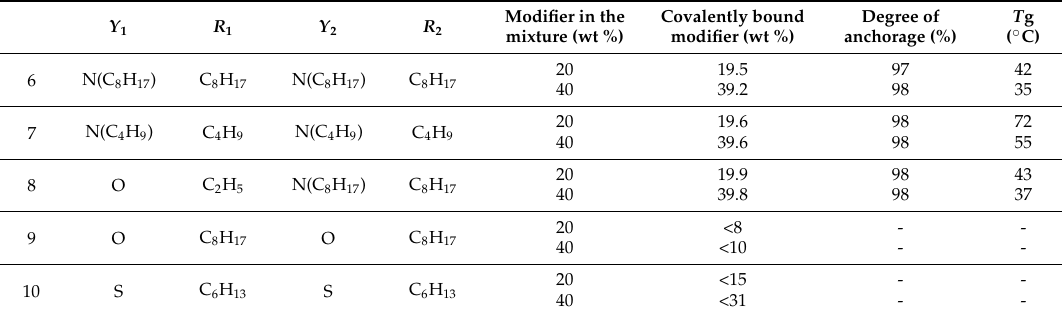
Table 2. Results for the anchoring reaction of modifier compounds to PVC.